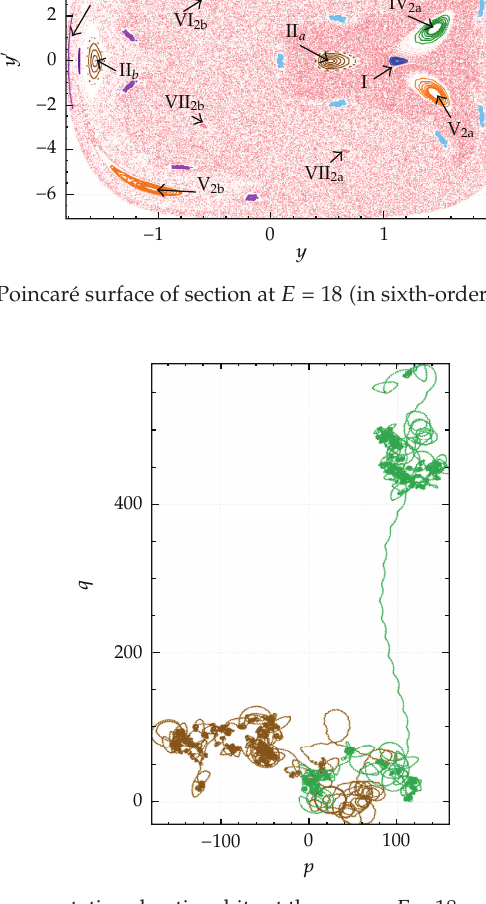
Figure 11: Representative chaotic orbits at the energy E (cid:7) 18 on the (cid:5) p,q (cid:6)